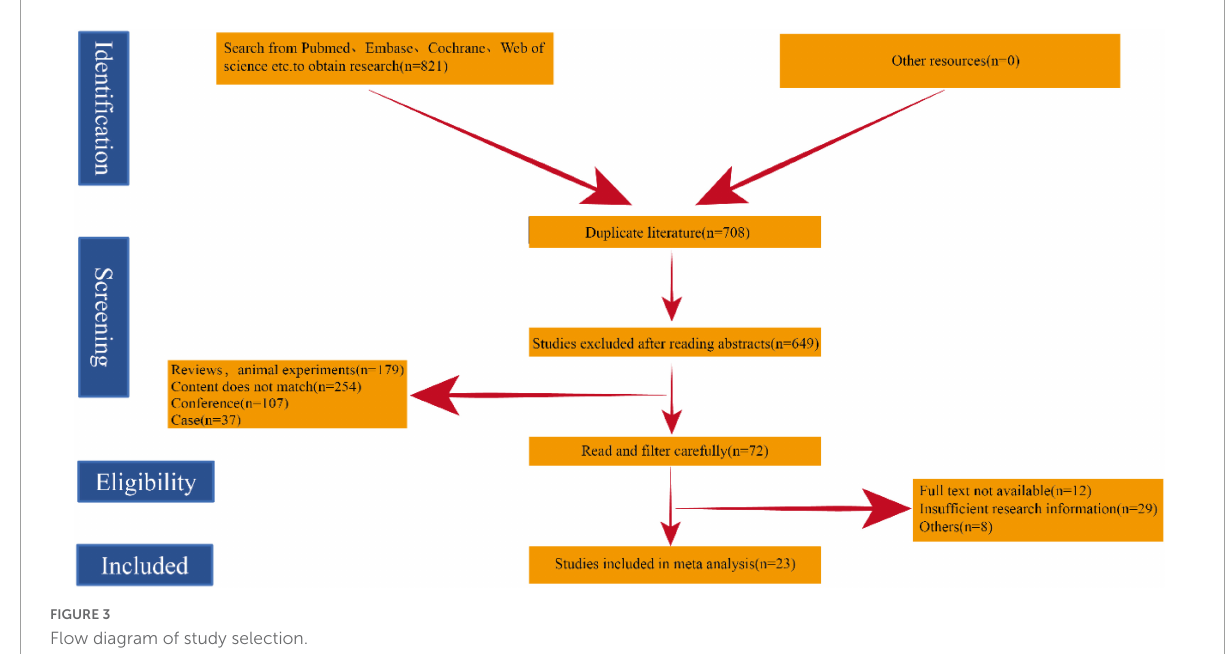
FIGURE3 Flow diagram of study selection.